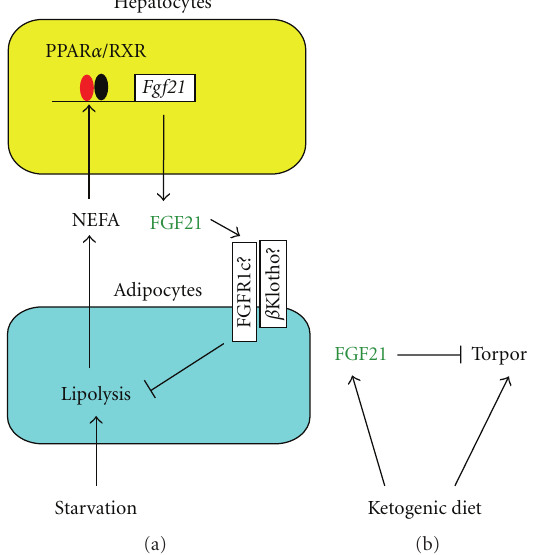
Figure 2: Mechanism of action and regulatory mechanism of the gene expression of FGF21. (a) Hepatic Fgf21 expression is induced by the activation of PPAR α . NEFA binds to and activates PPAR α . The ligand-bound PPAR α forms a heterodimer with RXRs and induces the expression of Fgf21 . The FGF21 inhibits lipolysis in adipocytes. In cultured adipocytes, FGF21 signaling is transduced by activating the β Klotho-FGFR1c complex. However, FGF21 signaling can be transduced in β Klotho knockout mice, indicating the existence of a β Klotho-independent FGF21 signaling pathway. The regulatory process forms a negative feedback loop in the control of lipolysis by FGF21. (b) Feeding with a ketogenic diet (KD) mimics the metabolic conditions of chronic starvation. KD induces hepatic Fgf21 expression and torpor. FGF21 attenuates torpor induced by